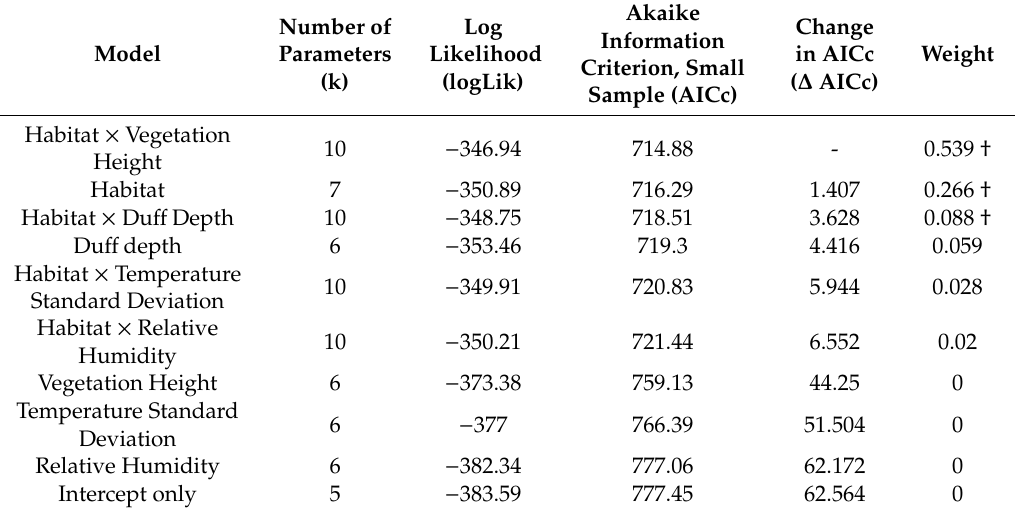
Table 3. Model selection for environmental variables affecting the abundance of A. americanum adults. Models with interaction terms include the main effects.